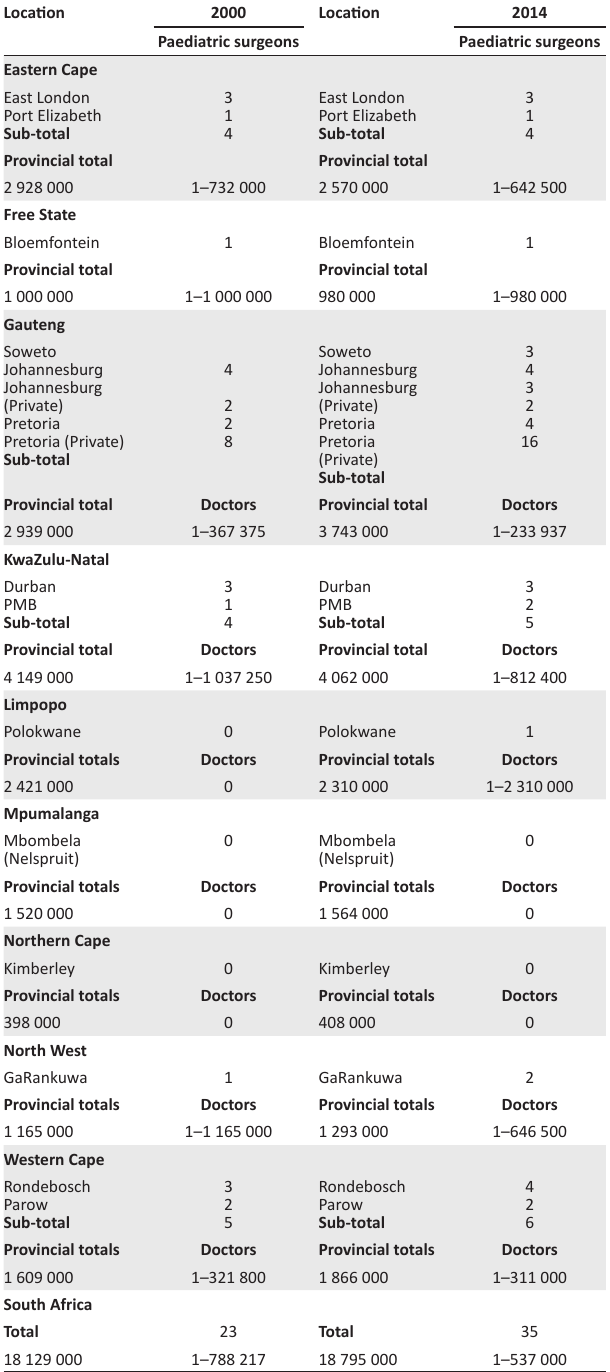
TABLE 9: The number of paediatric surgeons in each province between 2000 and 2014.